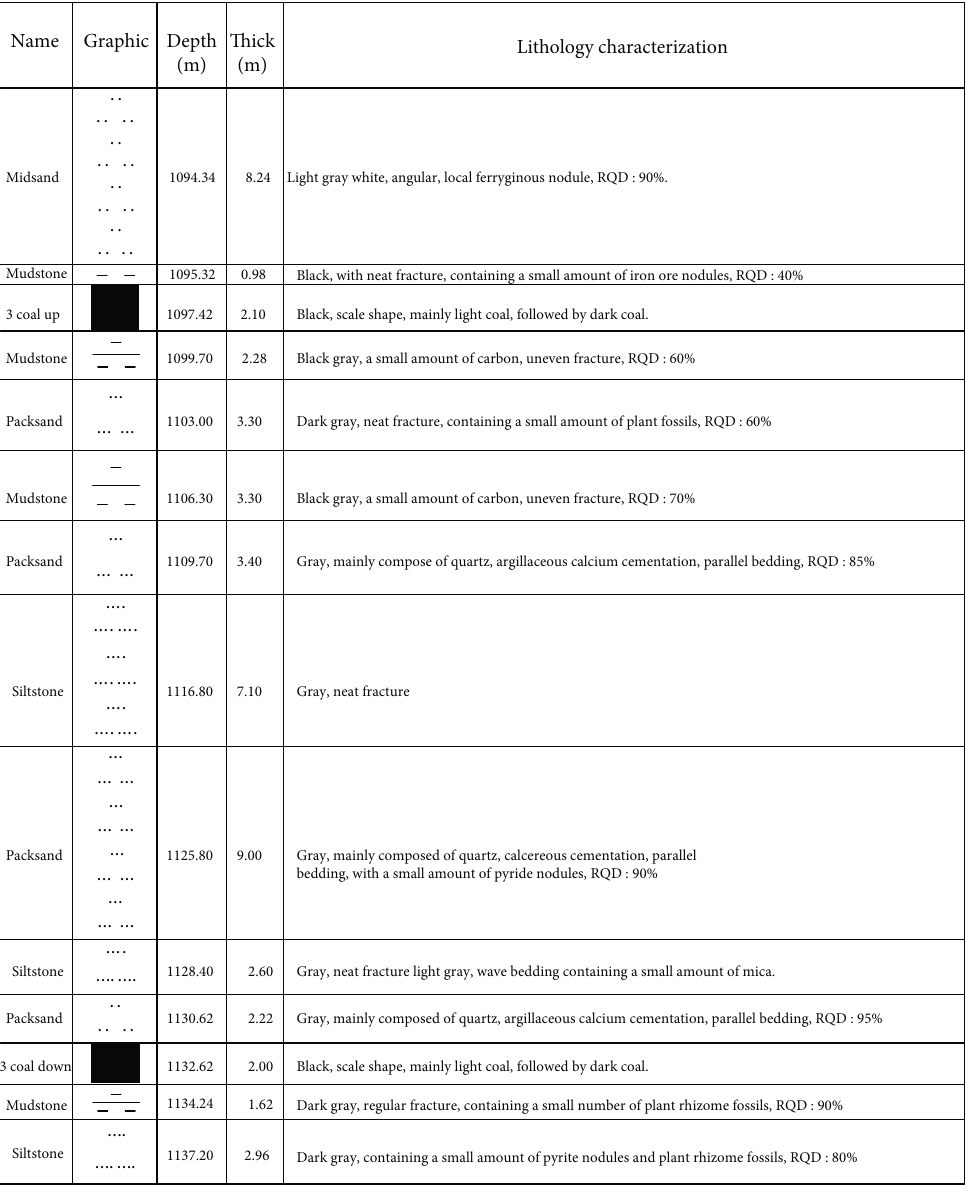
Figure 1: The coal seam borehole